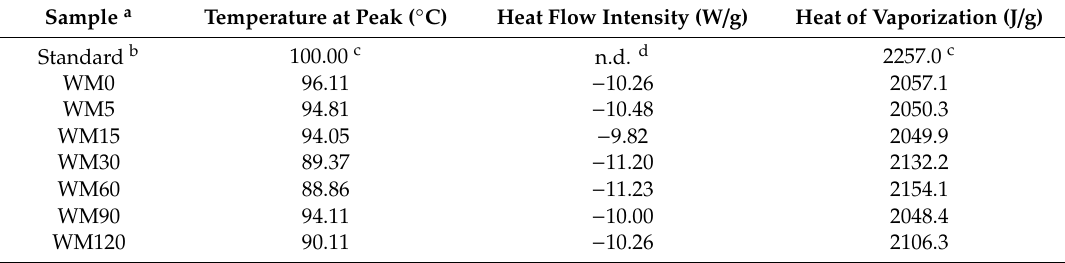
Figure 6. Differential scanning calorimetry (DSC) diagrams of the water saturated with methane treated with GP for 0 to 120 min. Speed: 10 °C/min. Table 2. Characteristics of the differential scanning calorimetry (DSC) curves .